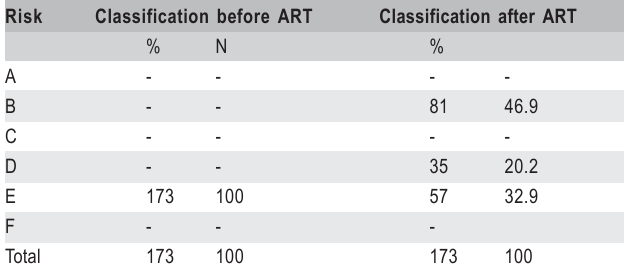
Table 3. Distribution of the risk evaluation among schoolchildren before and